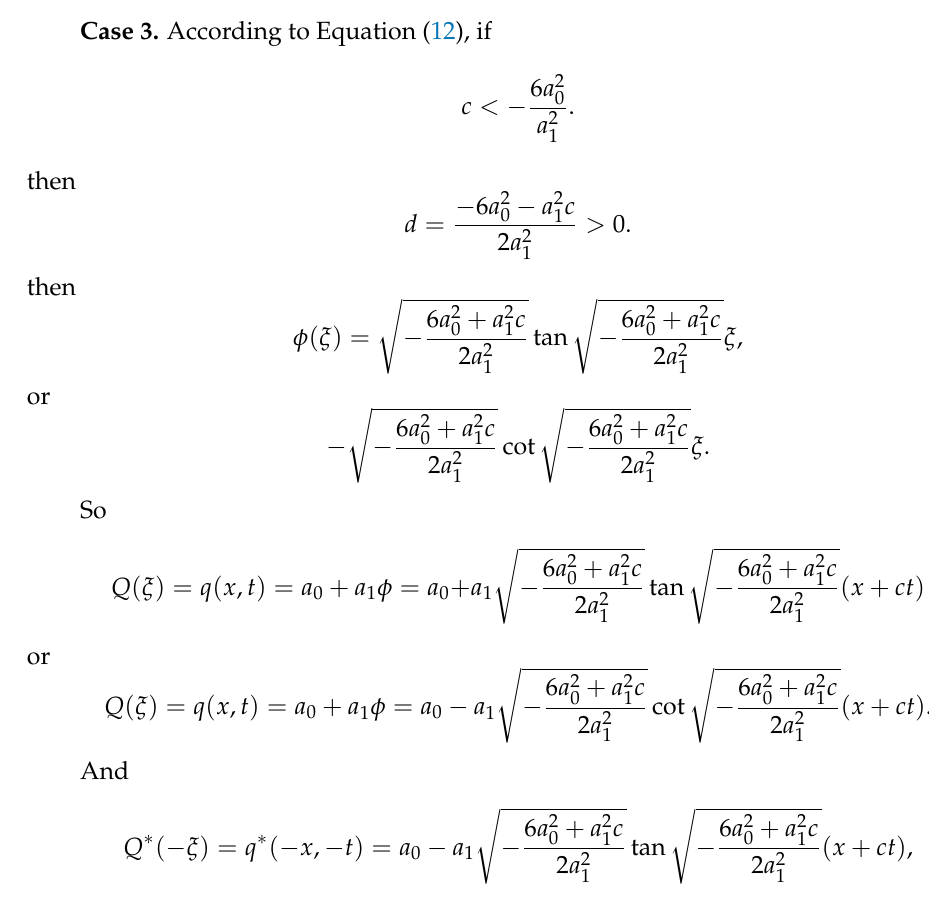
Figure 2. Graph of solution (29) taking the plus